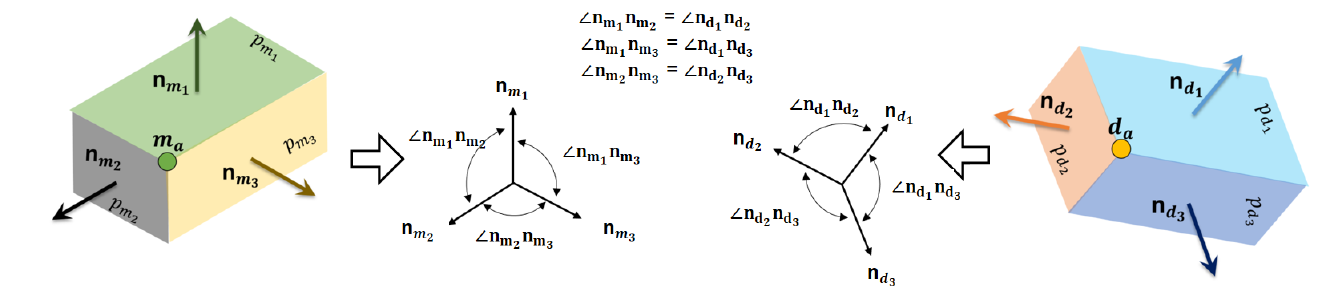
Figure 5. Verification of the relative angles between the parent planes of two potential matching corner points using their